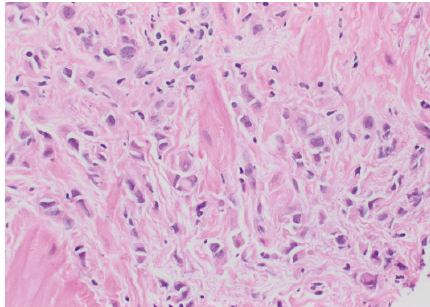
Figure 3: Hematoxylin and eosin (H&E) stain of FNA from gastric antrum showing tumor cells admixed with large pink bundles of muscle.